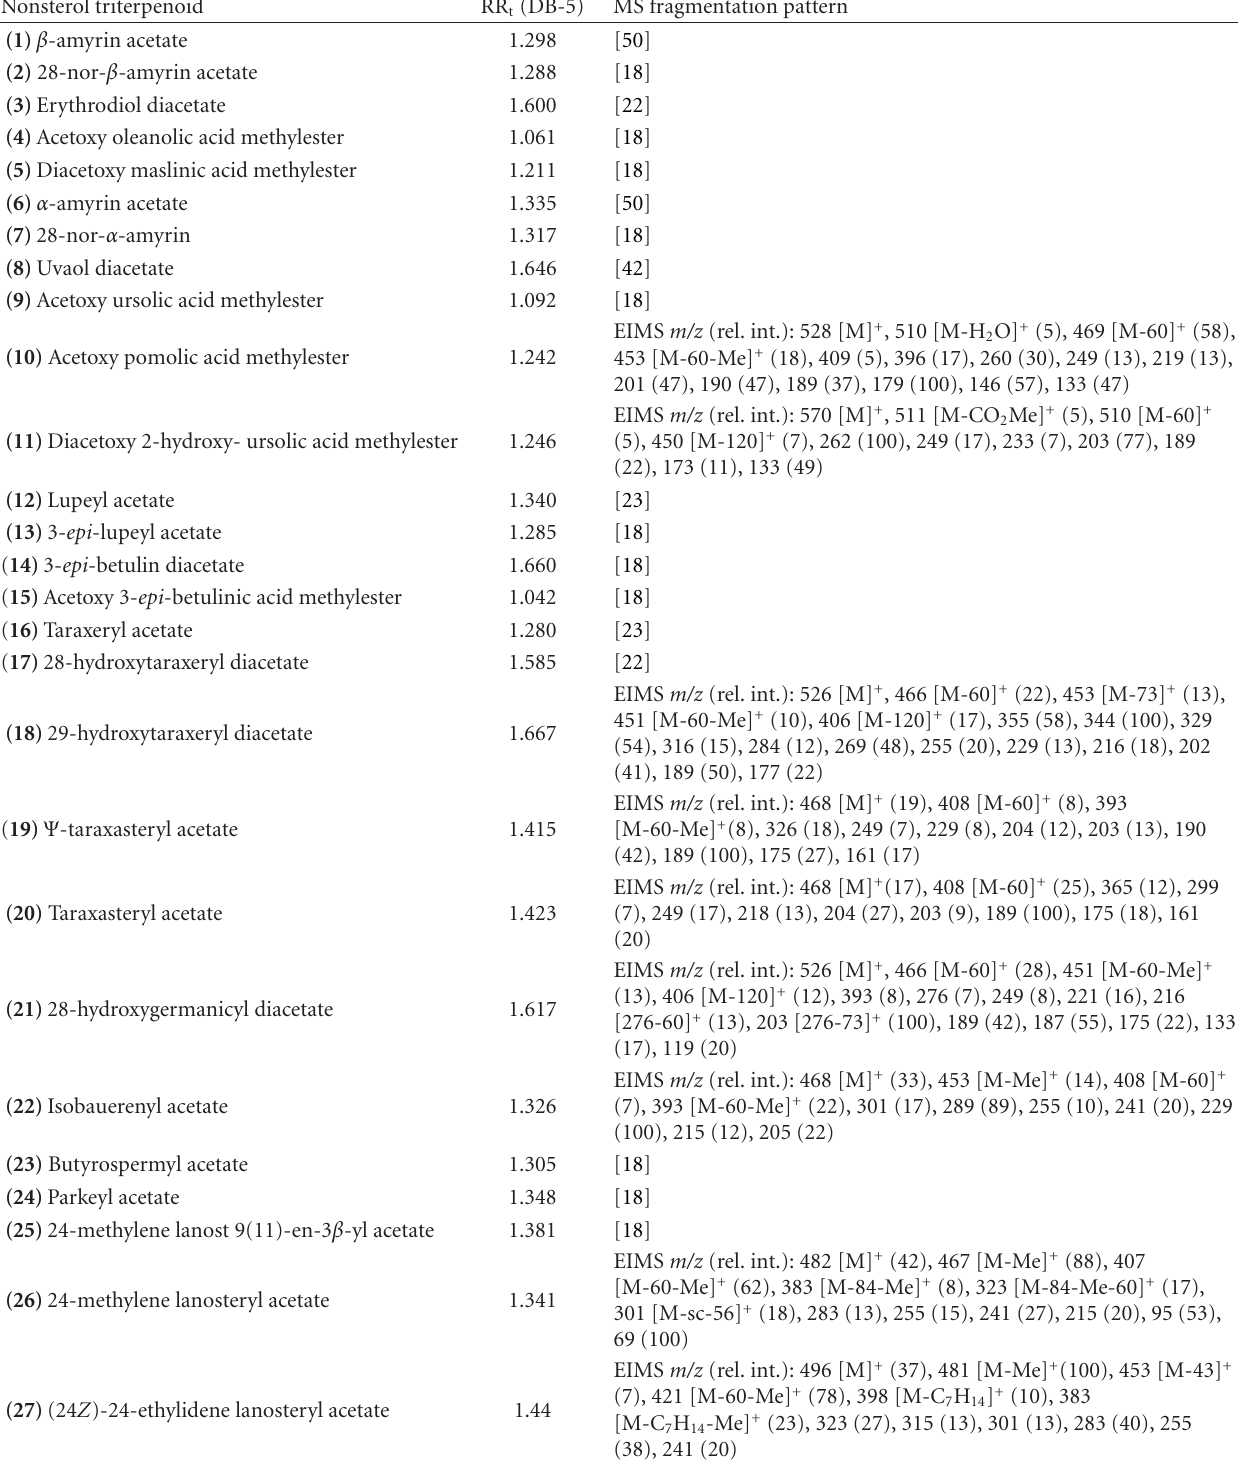
Table 1: GC-MS data of nonsterol